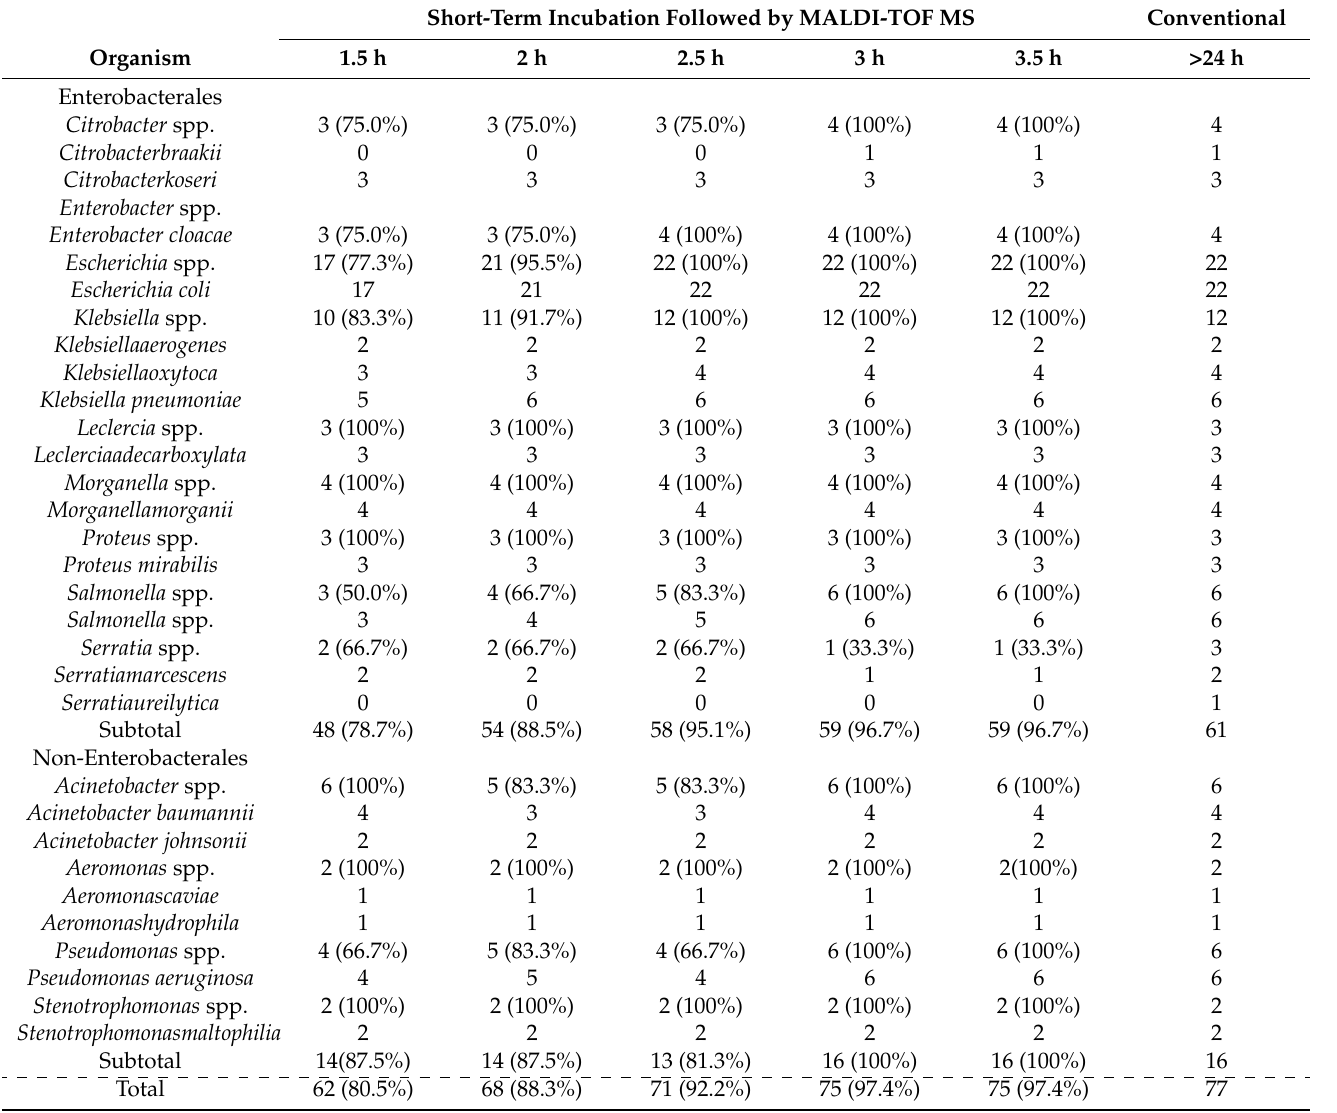
Table 2. Gram-negative bacteria identified by the short-term incubation (3.5 h) were concordant to those from the conven- tional